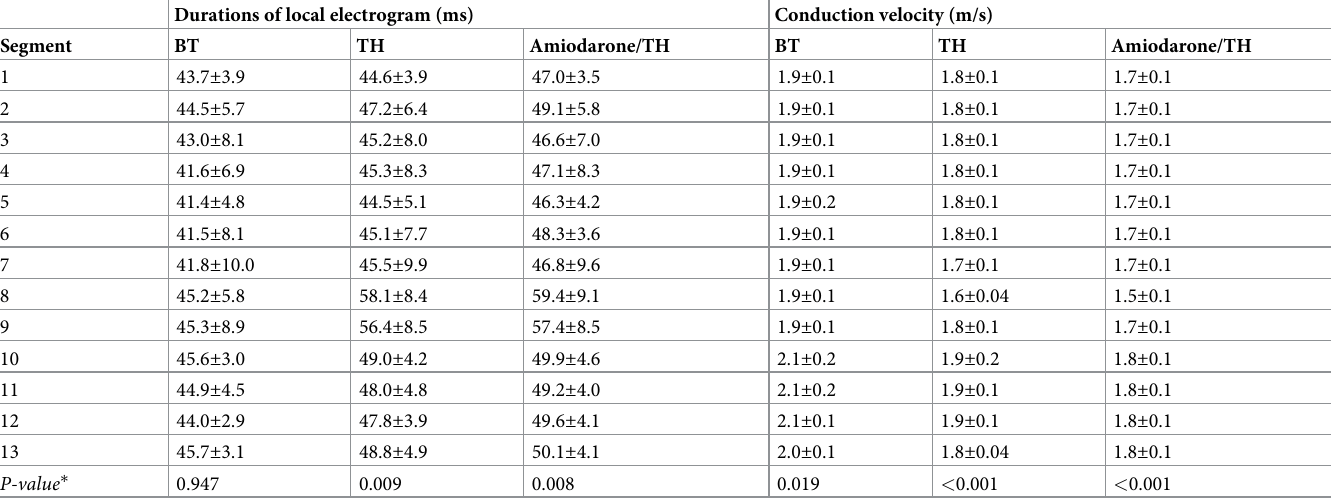
Table 3. Electrophysiological parameters in different epicardial segments during right ventricular pacing. Durations of local electrogram